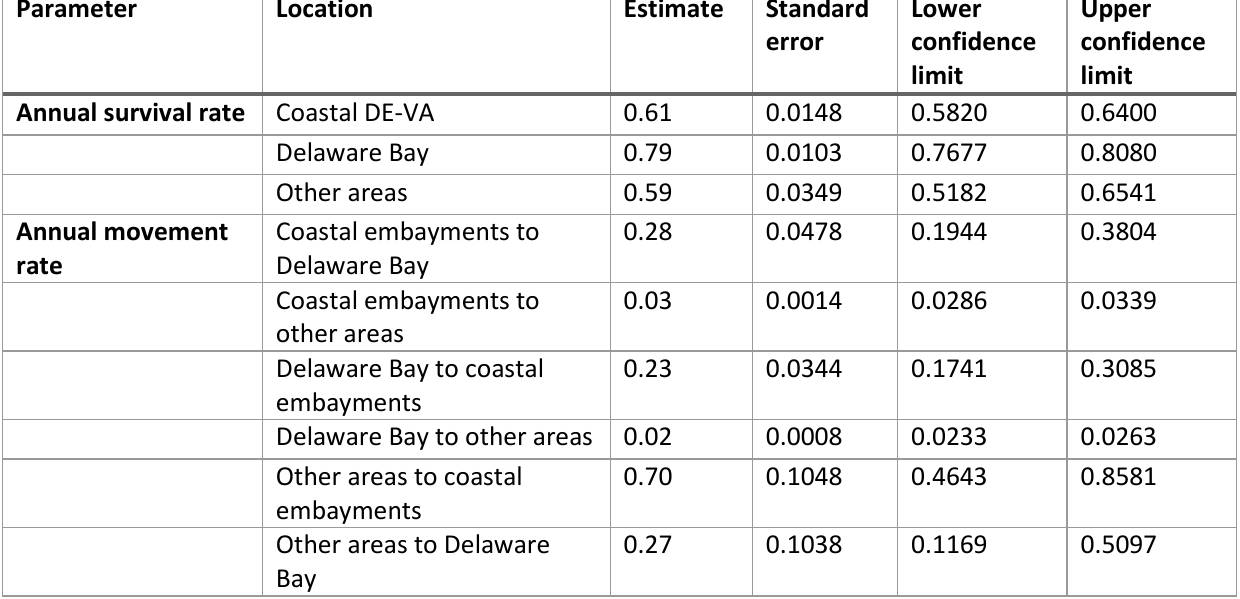
Table 6. Annual survival and movement rates for Delaware Bay and coastal embayments in Delaware and Virginia for the years 2003 to 2017 estimated from multi-state model using program